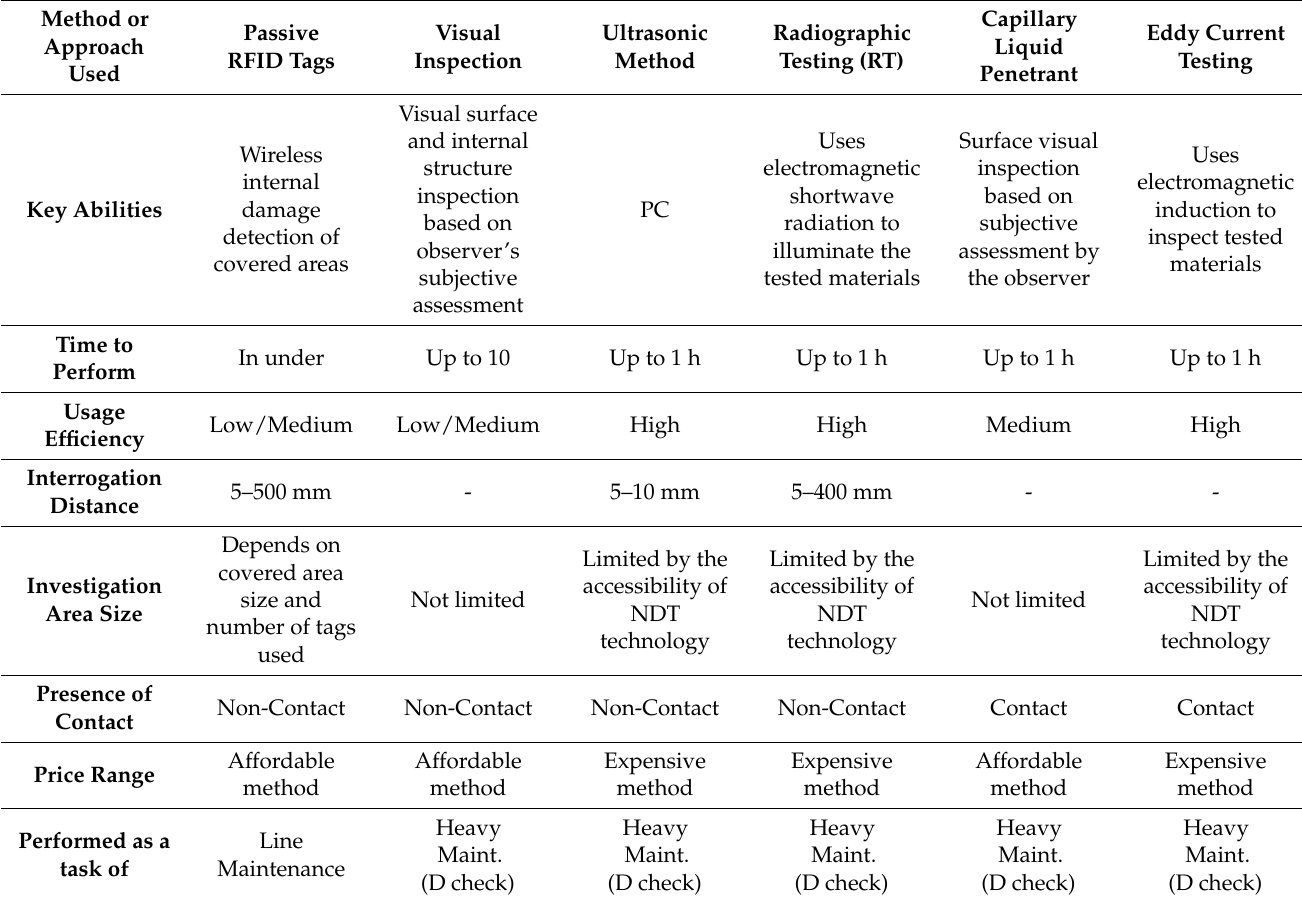
Table 6. Comparison of commonly used NDT methods for composite materials with the proposed RFID-based method; specifications based on